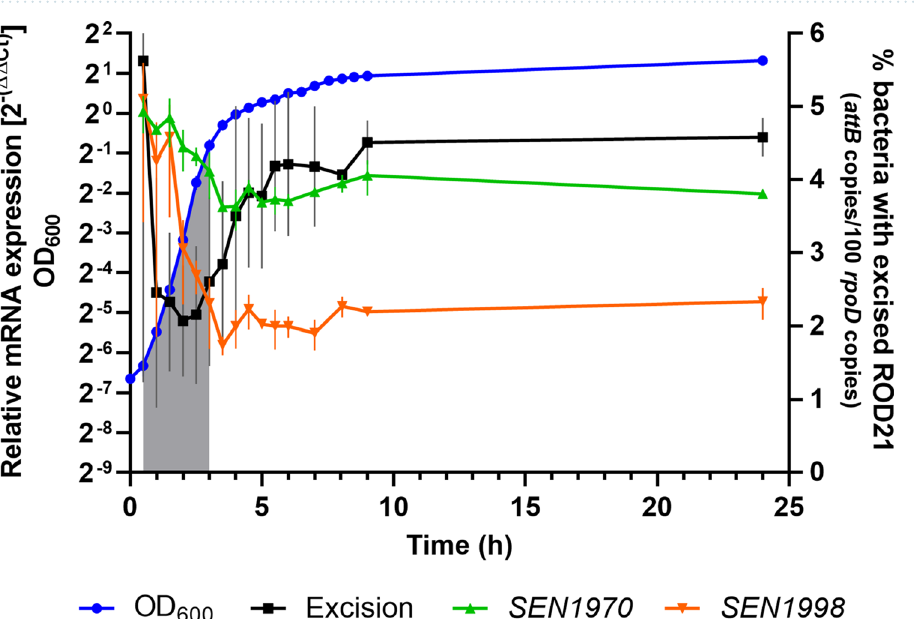
Figure 5. The excision of ROD21 increases during the stationary phase of growth as the expression of SEN1970 and SEN1998 decreases. ROD21 excision, and SEN1970 and SEN1998 expression patterns during the growth of Salmonella ser. Enteritidis P125109 in LB at 37 °C with shaking. The gray area represents the logarithmic phase of growth. Values are the mean ± SD of two independent